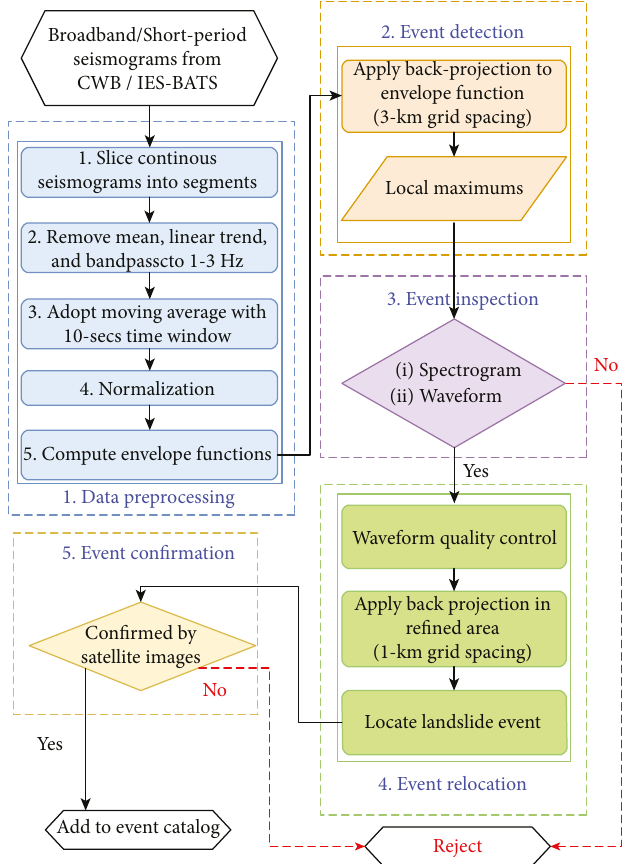
Figure 4: A fl owchart of our landslide detection/location system. The fi ve major components of the system are marked with colored dash